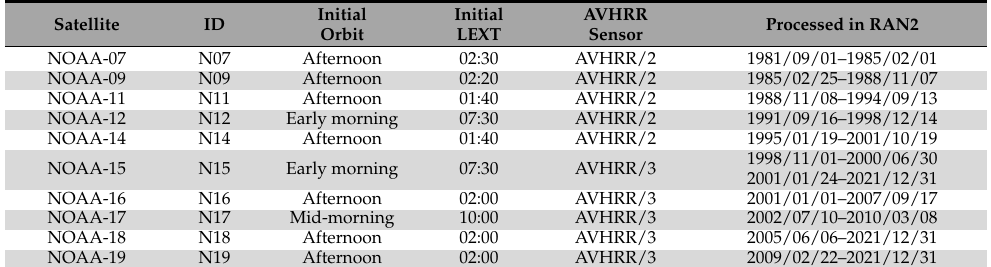
Table 1. POES data processed in RAN2. Table 1. Data processed in RAN2 (Occasional gaps up to several days may occur).